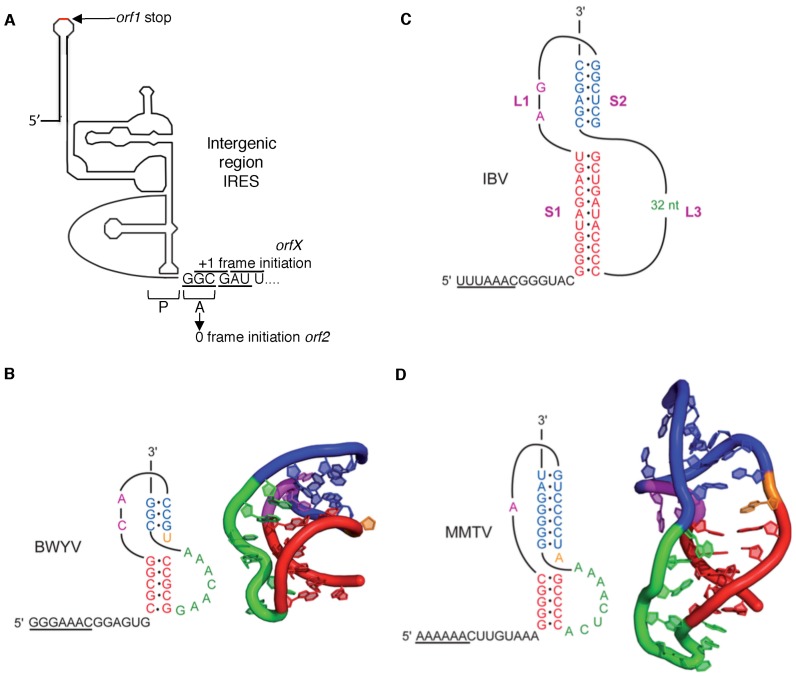
2D and 3D models of RNA structures that promote access to alternative reading frames in viral genes. (A) The intergenic Internal Ribosome Entry Site (IRES) of the dicistrovirus, Israeli acute paralysis virus, causes most ribosomes to initiate 1 base 5′ of where the others initiate. Stimulators for ribosomal frameshifting are shown for (B) beet western yellows virus (BWYV), (C) infectious bronchitis virus (IBV) and (D) mouse mammary tumor virus gag/pro (MMTV). Slippery sequences are underlined. Reproduced in part from Brierley, I., Gilbert, R.J.C. and Pennell, S., Pseudoknot-Dependent Programmed -1 Ribosomal Frameshifting: Structures, Mechanisms and Models (2010) In: Atkins, J.F. and Gesteland, R.F. (eds.), Recoding: Expansion of Decoding Rules Enriches Gene Expression. Springer New York, New York, pp. 149–174, with permission from Springer.